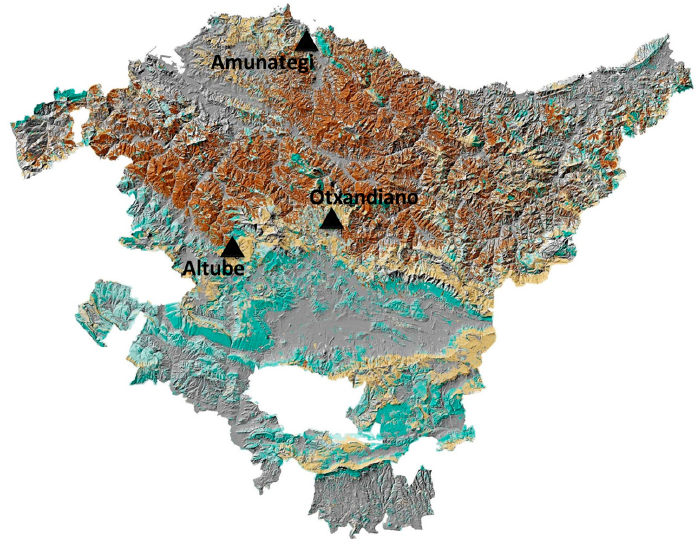
Figure 1. Location of Amunategi, Altube, and Otxandiano stands.